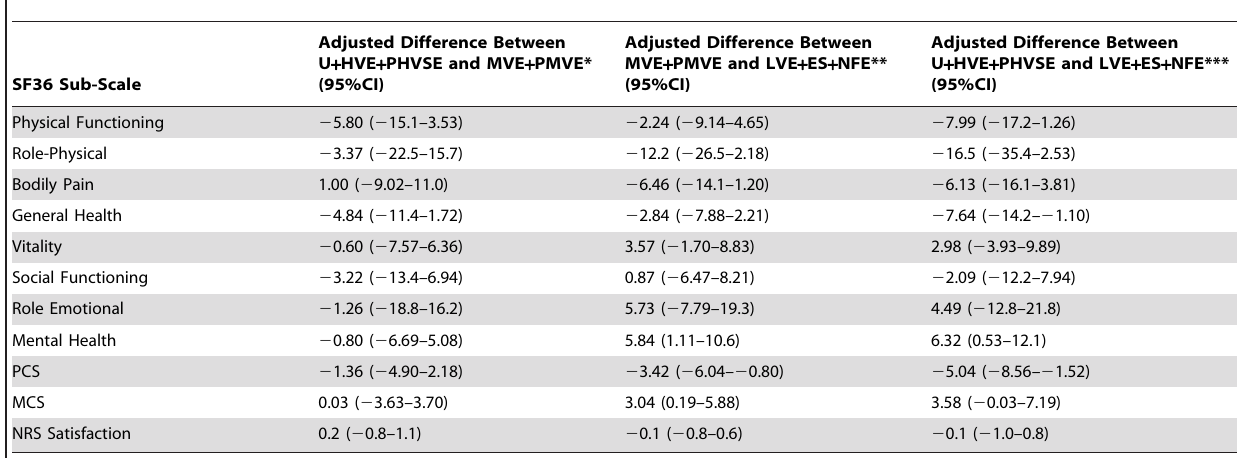
Table 9. Adjusted Difference in Improvement in Health-Related Quality of Life and Satisfaction after Knee Replacement::A Comparison Between Patients with different Completed Levels of